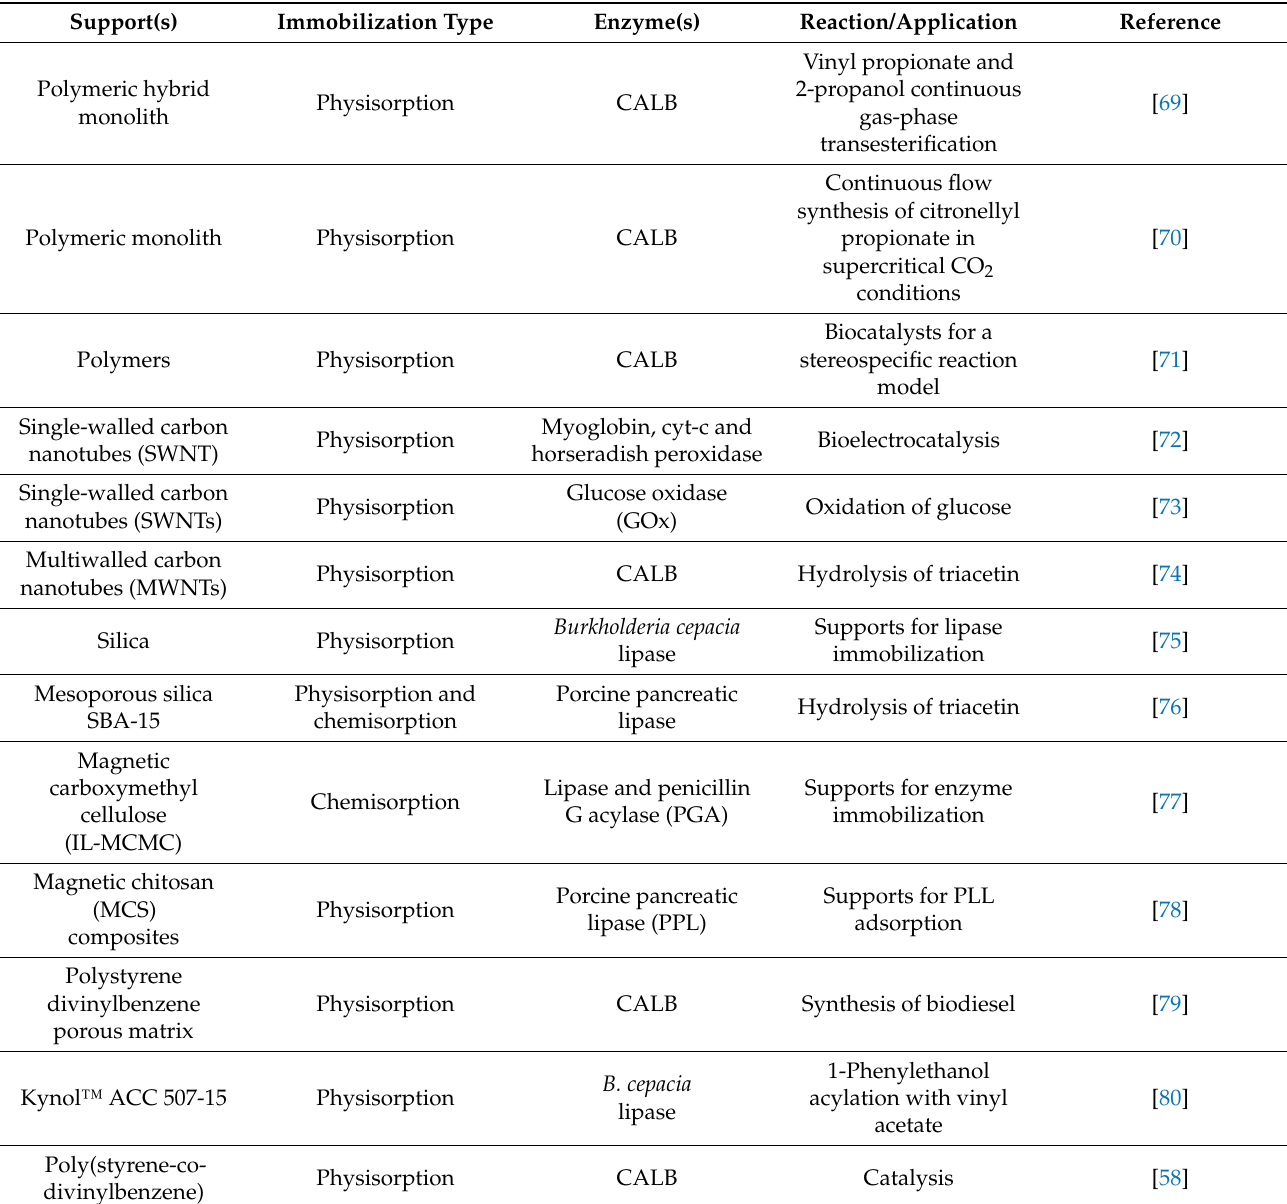
Table 1. Summary of the reported studies showing the potential of SILs in the biocatalysis